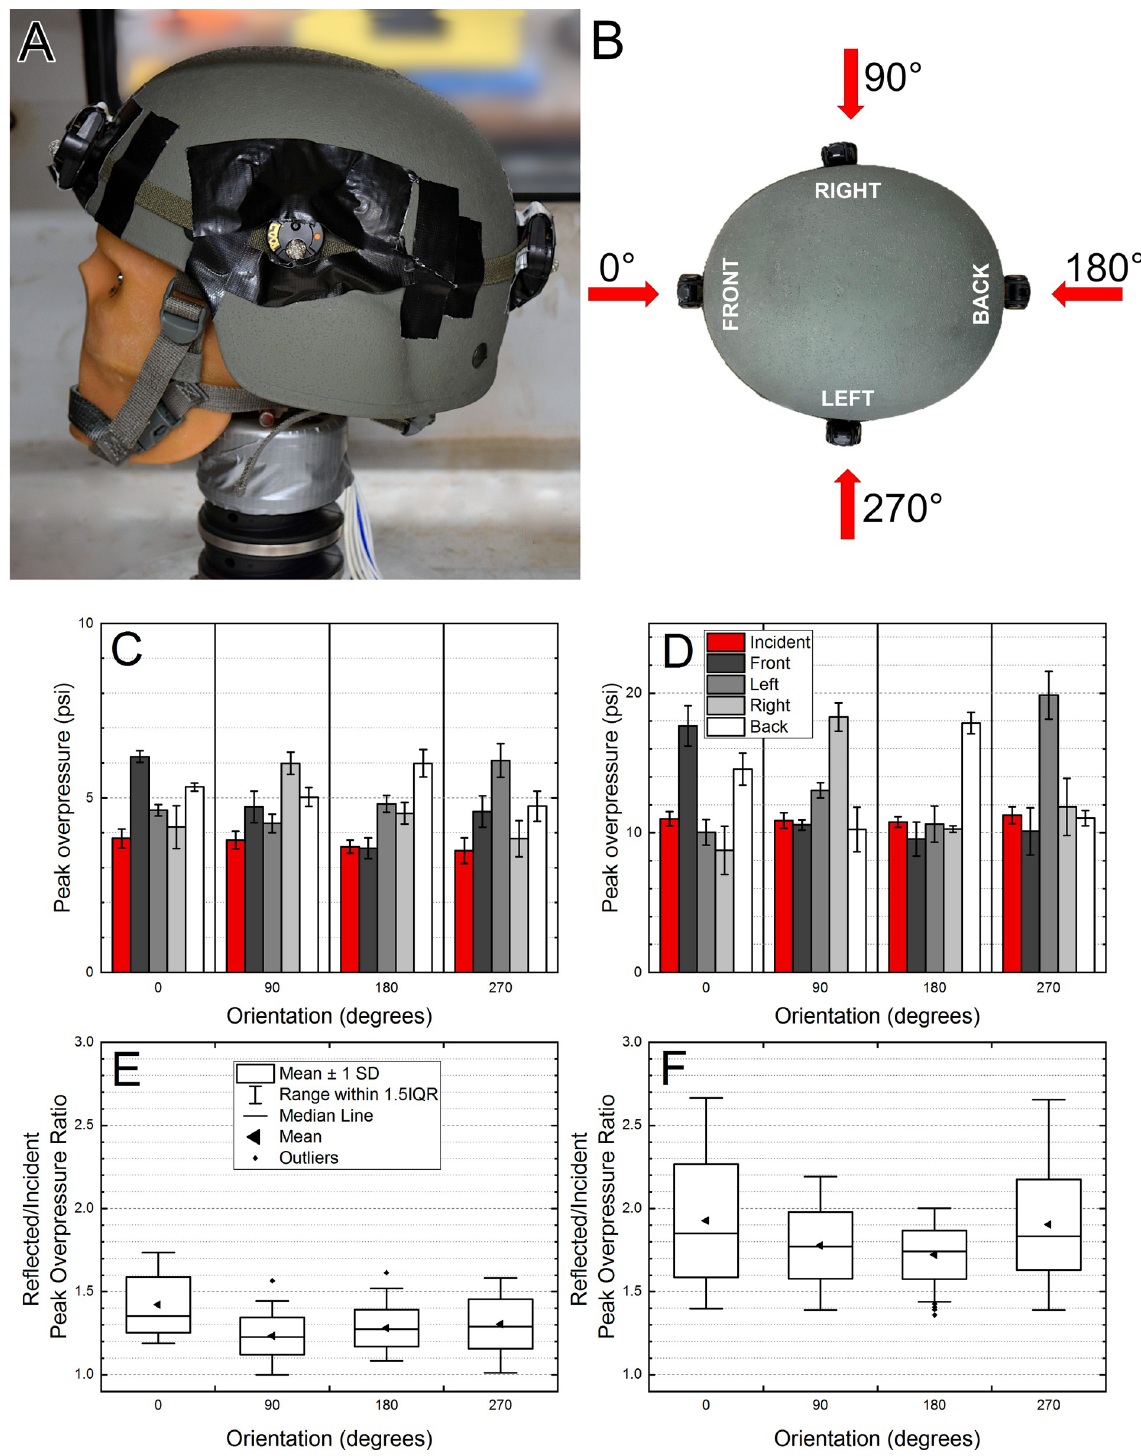
Fig 3. The quantification of the overpressure waveforms recorded by the B3 Blast Gauge sensors attached on the ACH helmet (A). Four sensors were used to measure the external pressure distribution on the helmet, which was rotated in 90 degrees intervals (B), and the direction of shock wave propagation is indicated by red arrows. The average overpressure reported by individual sensors exposed to a single shock wave with nominal intensity of 5 psi (C) or 10 psi (D) is presented. The reflected-to-incident peak overpressure (E) and impulse (F) ratios are also